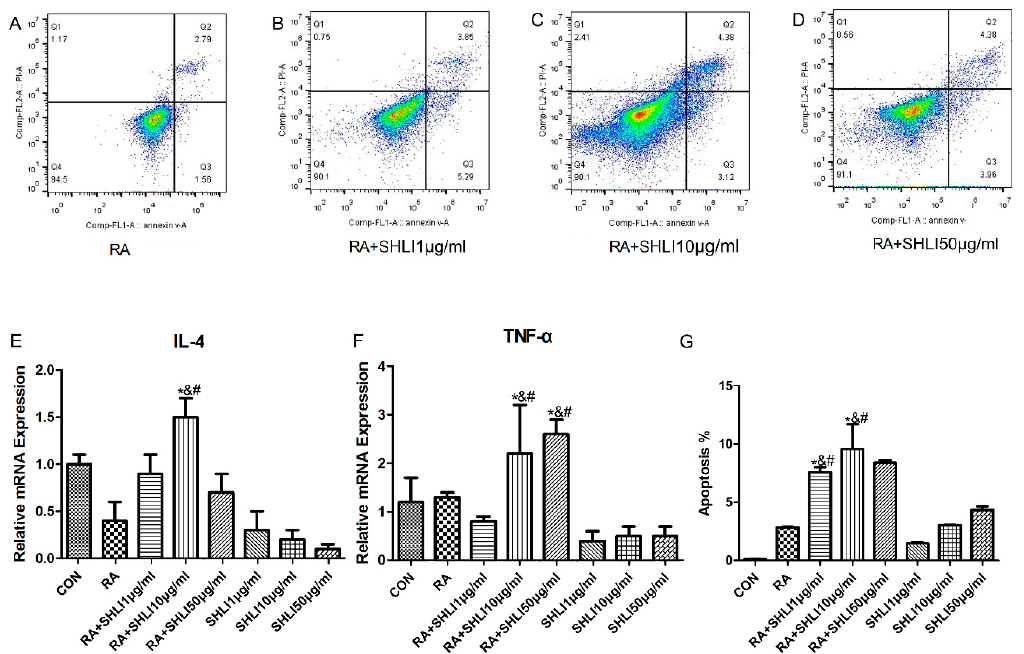
Figure 4. SHLI increased the apoptosis rate and inflammatory factors level of DSG1-deficient Hacat cells. ( A – D , G ) Apoptosis rate analysis by flow cytometry. The mRNA levels of IL-4 ( E ) and TNF- α ( F ) were increased when different concentrations of SHLI affected the DSG1-deficient Hacat cells. Data are presented as mean ± S.D. * p < 0.05 vs. normal, # p < 0.05 vs. RA, and p < 0.05 vs. SHLI.